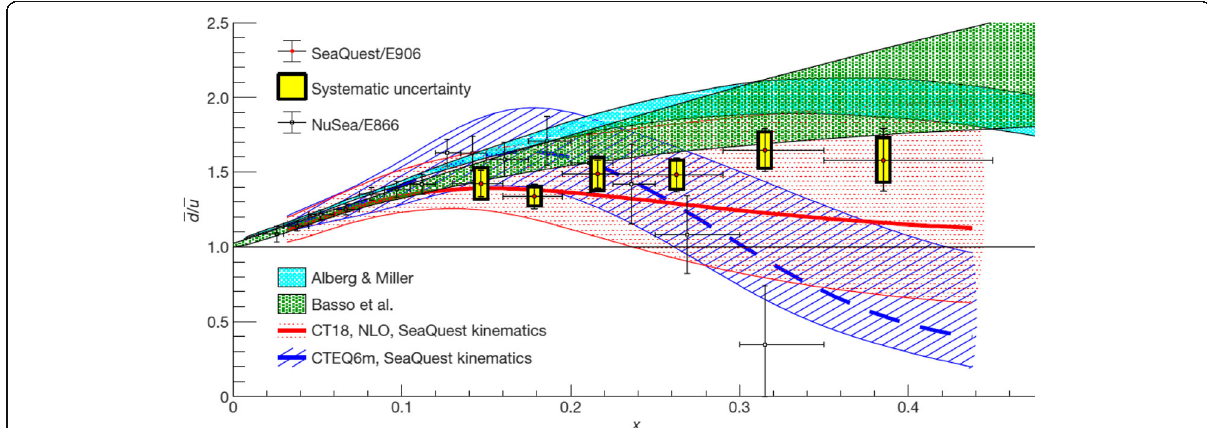
Fig. 1 Ratios of d ð x Þ to u ( x ) in the proton (red filled circles) from the SeaQuest/E906 data, based on next-to-leading-order calculations of the Drell-Yan cross sections. Results of the previous measurement by the NuSea experiment, the calculated ratios with two PDFs, and the predictions of two theoretical models are shown for comparison. The figure is taken from Nature 590, 561